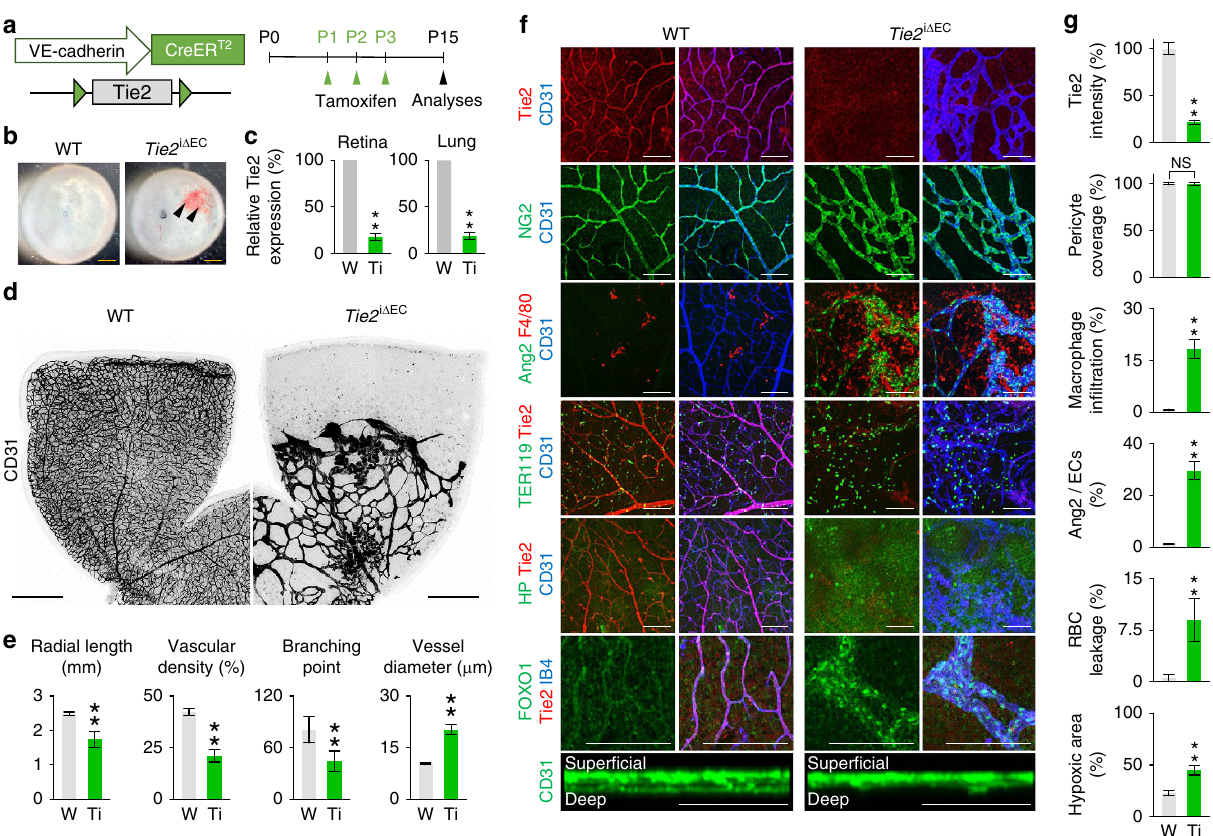
Figure 5 | Tie2 is indispensable for retinal vascular growth and BRB maturation. ( a ) Diagram depicting the experiment schedule for EC-specific depletion of Tie2 in retinal vessels from P1 and their analyses at P15 using Tie2 i D EC mice. ( b ) Images of inner surface of retinal cup of WTand Tie2 i D EC mice. Hemorrhages (arrowheads) are seen in Tie2 i D EC mice. ( c ) Relative levels of Tie2 mRNA in the lysates of retina and lung of Tie2 i D EC mice (Ti) mice versus WT mice (W). ( d , e ) Images of CD31 þ vessels and comparisons of indicated parameters in W ( n ¼ 6) and Ti ( n ¼ 6). ( f ) Images of retinal vascular phenotypes in W and Ti. Note that enlarged IB4 þ or CD31 þ vessels with adequate NG2 þ pericyte coverage have scanty expression of Tie2, while high expression of Ang2 by vessels with profound F4/80 macrophage infiltration, TER119 þ RBC leakage, severe hypoxia with impaired deep vessel formation, and evident nuclear localization of FOXO1 are detected in retinas of Tie2 i D EC mice. ( g ) Comparisons of indicated parameters in W ( n ¼ 6) and Ti ( n ¼ 6). Error bars represent mean ± s.d. ** P o 0.01 versus WT by Mann–Whitney U test. Scale bars, 100 m m (white) and 500 m m (yellow, black).